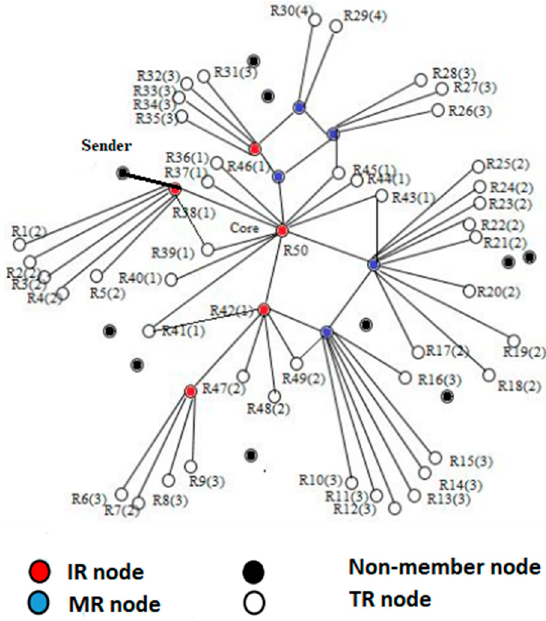
Figure 3. Mesh Formation.